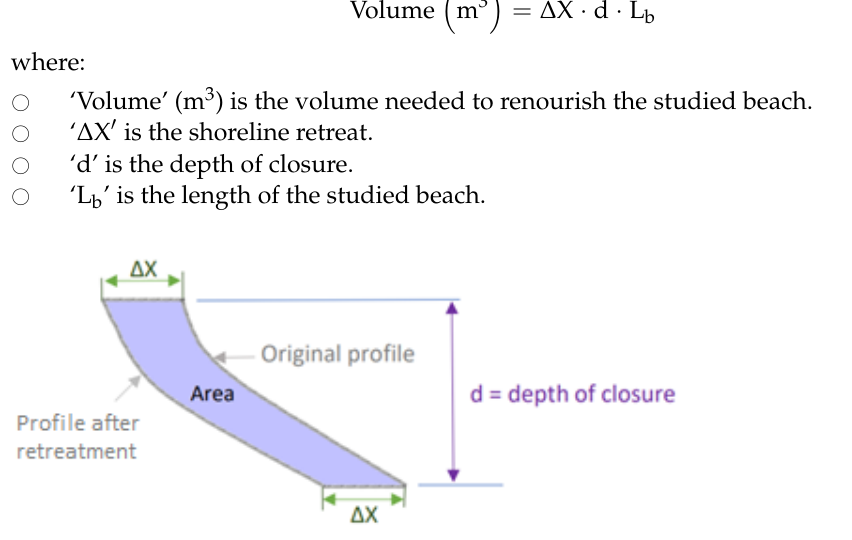
Figure 3. Retreat of active profile. Area to estimate the volume of sand requested.